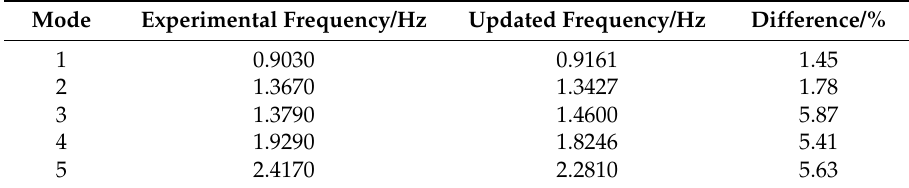
Table 4. The comparison between modified and real frequencies.